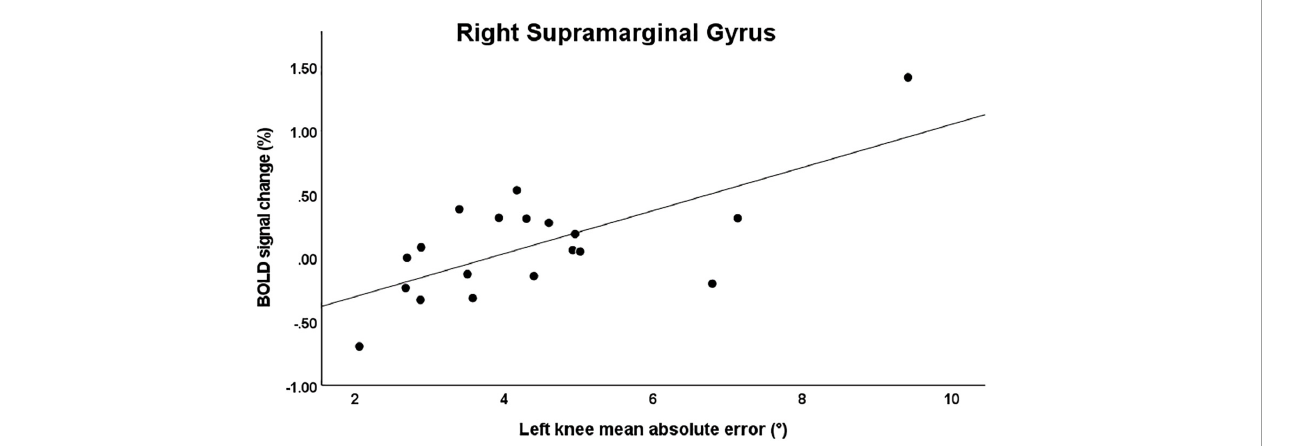
FIGURE4 Scatter plot illustrating the significant correlation between mean knee joint position sense absolute error for the left knee and simultaneous BOLD signal percentage change in the right supramarginal gyrus (MNI coordinates [X, Y, Z]: 60, –26, 48; r = 0.474, P = 0.040). Note that when removing the two most extreme values, this correlation was no longer statistically